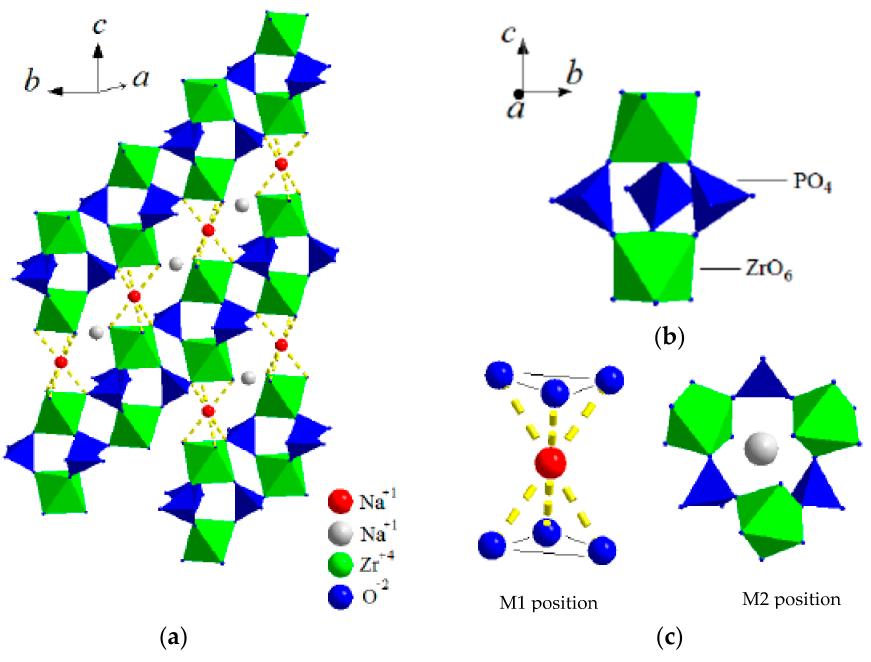
Figure A1. Fragment of the NaZr 2 (PO 4 ) 3 structure ( a ), structural unit of the Zr 2 (PO 4 ) 3 framework ( b ), and co-ordination polyhedra of framework cavities ( c ) [43]. The difference in the co-ordination surroundings of cations in void positions M1